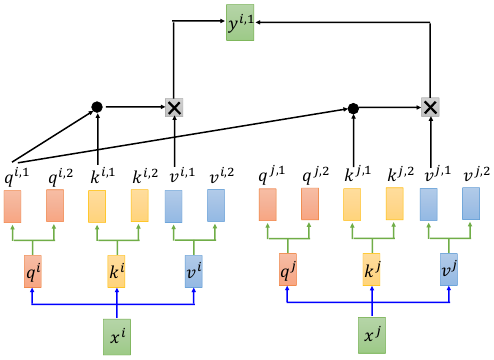
Figure 6. Multi-head